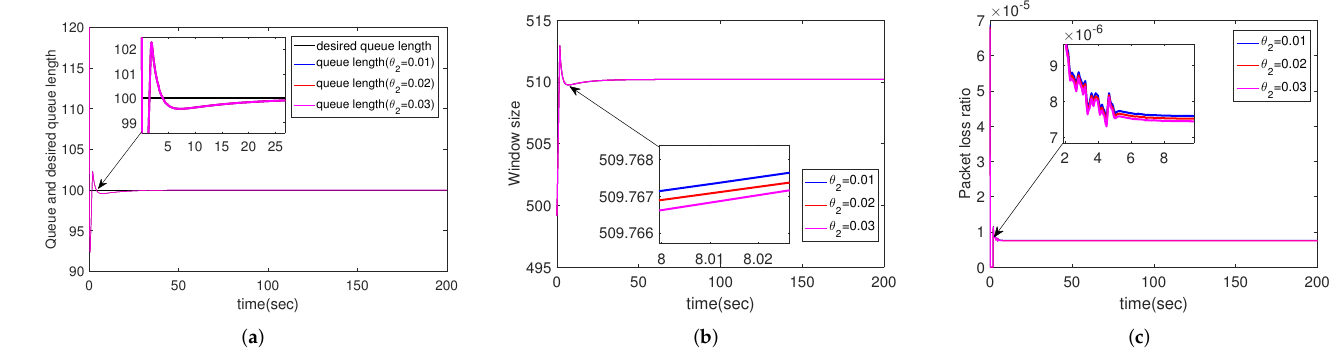
Figure 6. Simulation results of multiple routers using CCAIB for different downlink packet loss ratios. Columns from left to right show the performance of CCAIB in ( a ) queue length stability, ( b ) window size and ( c ) packet loss ratio in the queue.